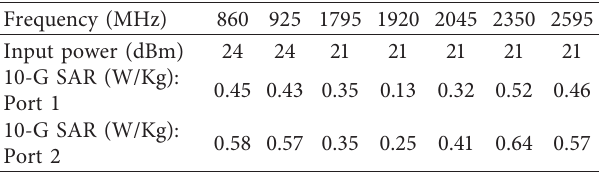
Table 2: Simulated SAR values for 10 g head tissue. Frequency (MHz) Input power